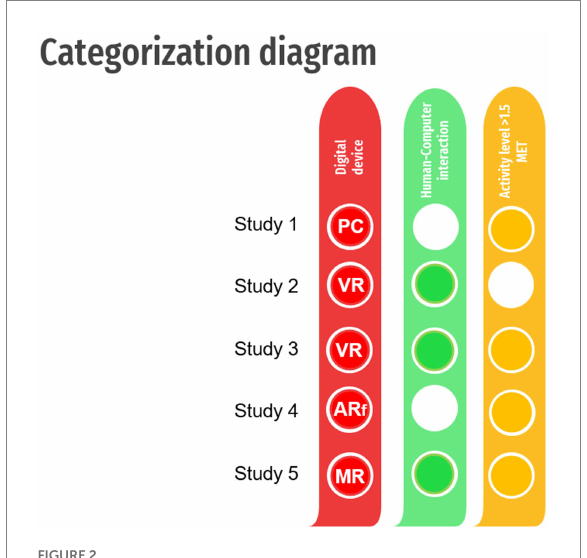
FIGURE 2 Categorization diagram of technology used in movement-related research. PC – personal computers and consoles with displays and controlling gadgets; XR, Extended Reality; AR, Augmented Reality with semi – (ARs) and fully-immersive (ARf) options; MR, Mixed Reality, VR, Virtual Reality; the white circles indicate no HCI or physical activity level below 1.5